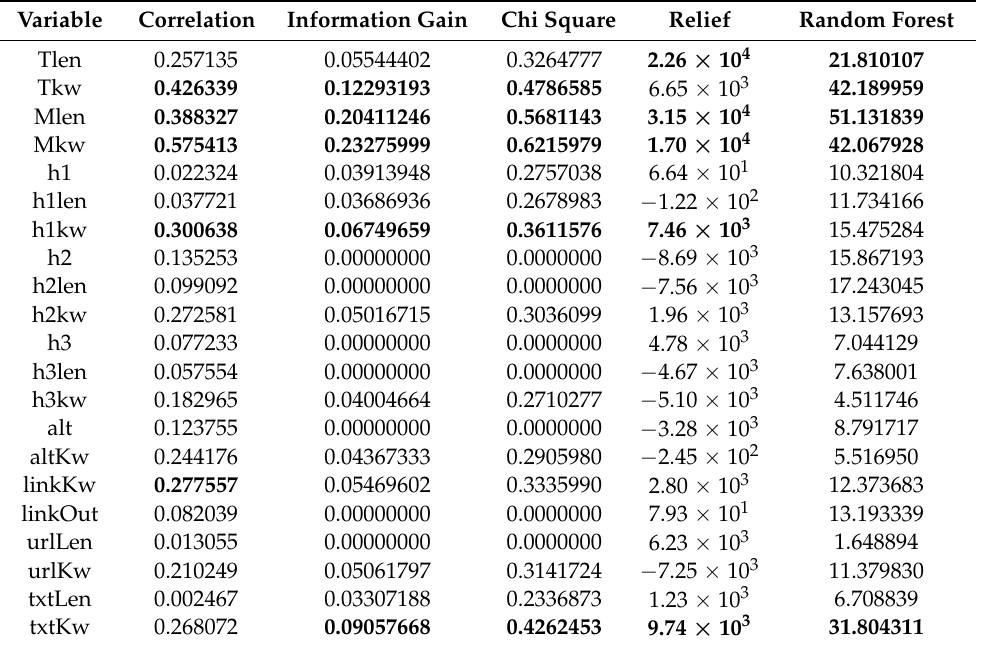
Table 6. Variable importance based on various tests.